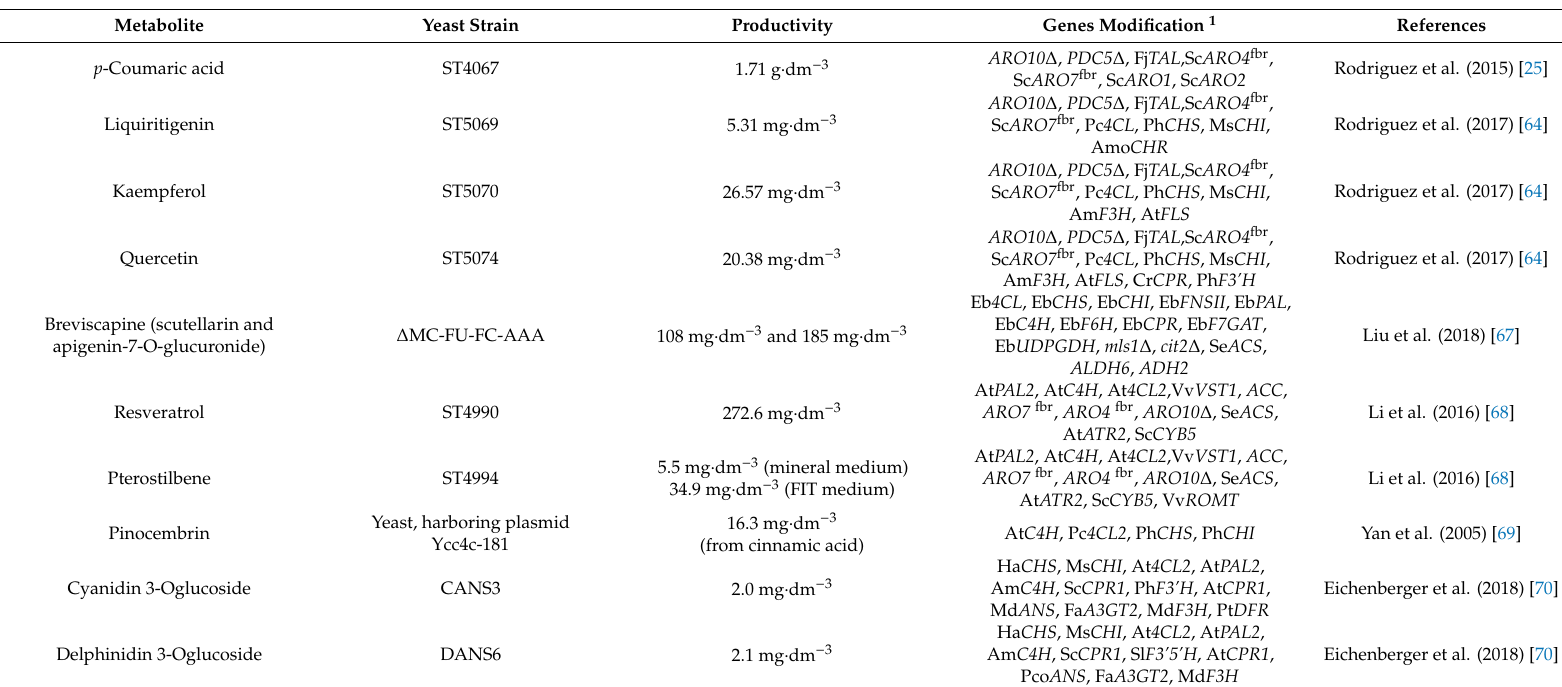
Table 1. Gene modification and the formation of polyphenolic compounds through recombinant Saccharomyces cerevisiae